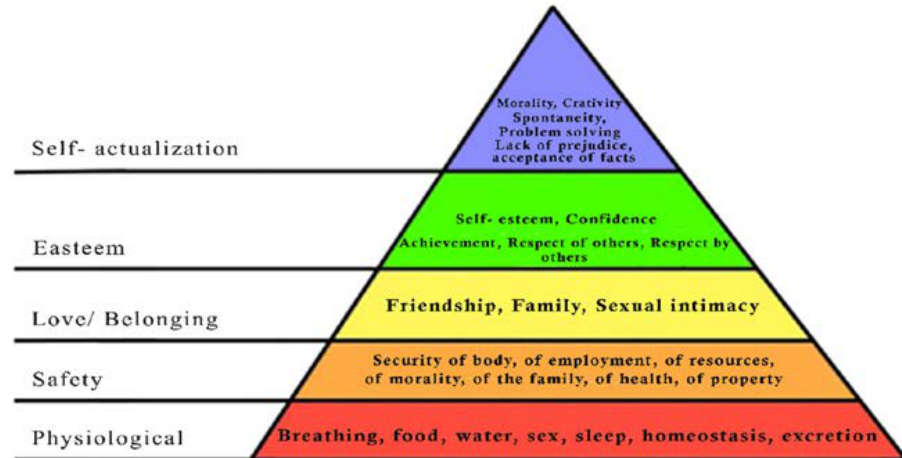
Fig. 1: Maslow needs pyramid (Maslow, 1996)